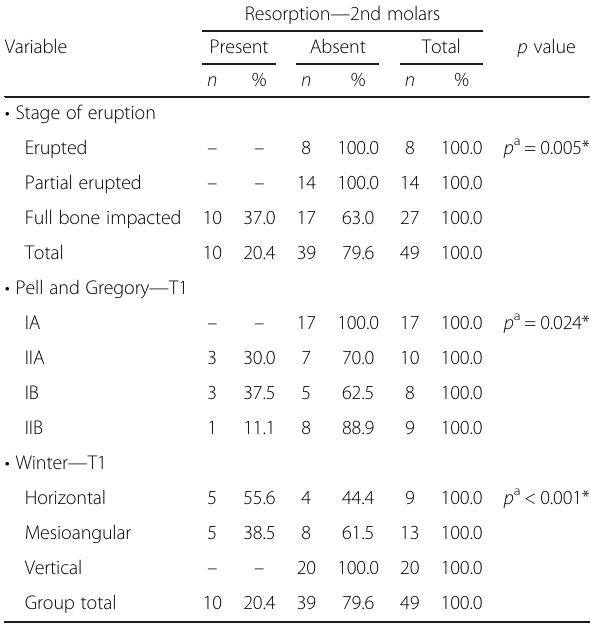
Table 3 Correlation of the root resorption of second molars according to the stage of eruption of the lower M3 positions at T1 Resorption — 2nd molars